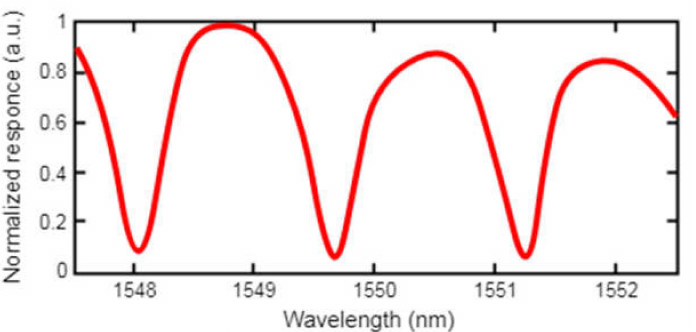
Figure 20. Normalized transmission spectrum of a MRR (Adapted with permission from Ref [36]. Copyright 2011, IEEE).